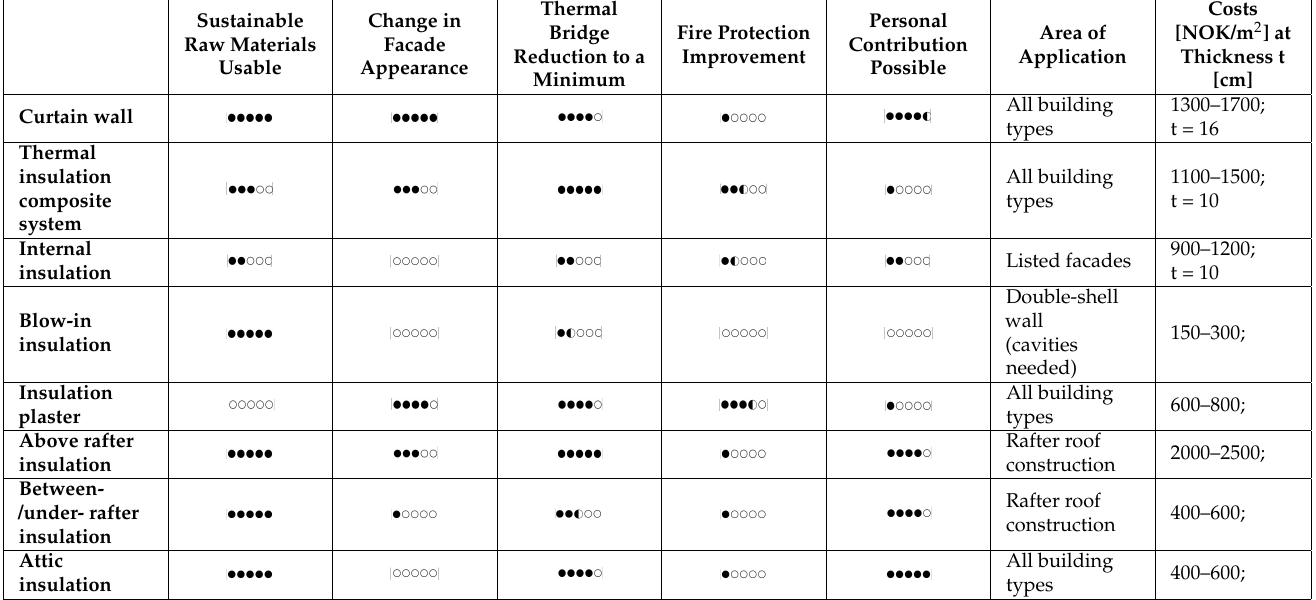
Table 5. Insulation techniques and their potential for self-renovation (Beck,